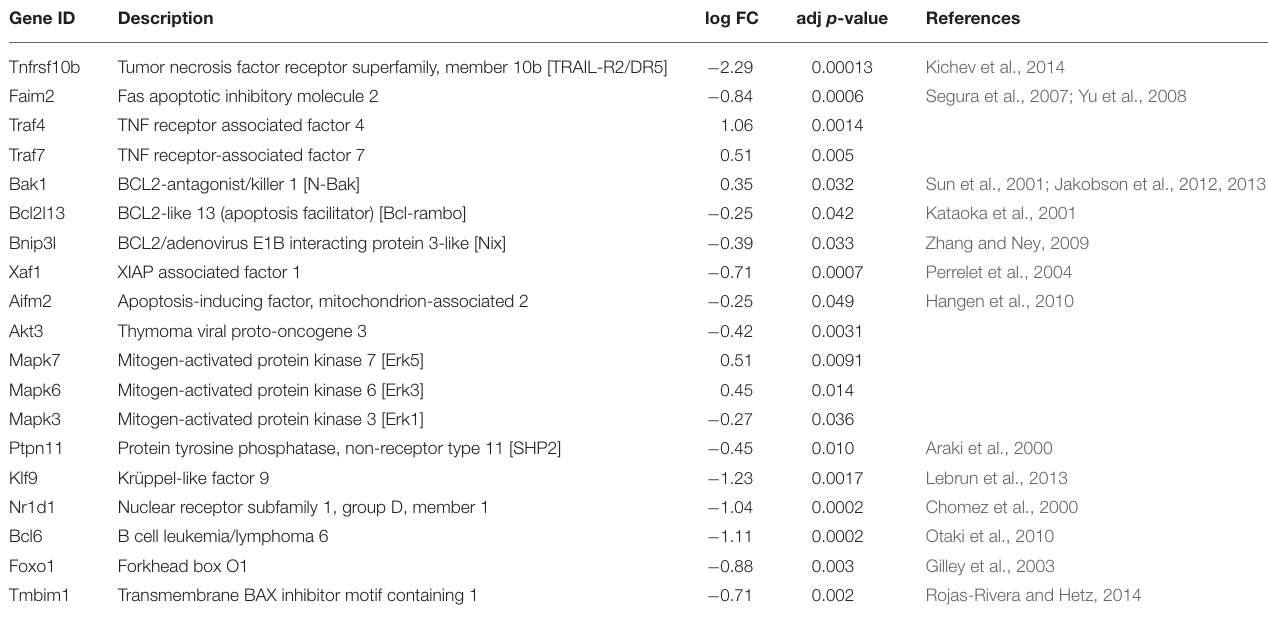
TABLE 7 | Genes related to apoptosis or cell survival that changed significantly during SCG neuronal maturation.